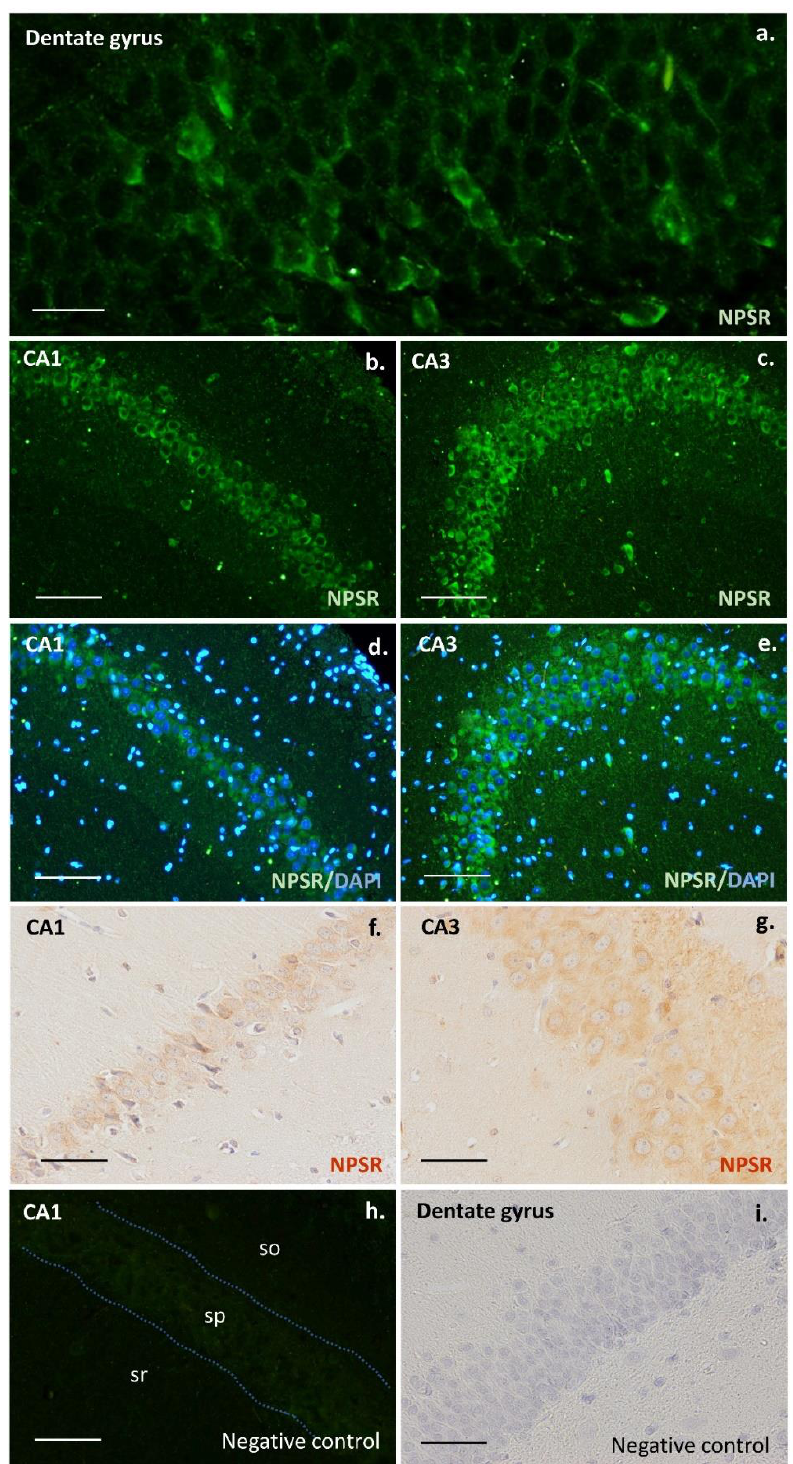
Figure 4. Neuropeptide S (NPSR) receptor-expressing neurons in the rat hippocampus. Immunopositive neurons in the dentate gyrus, CA1, and CA3 areas of control rats. Fluorescence, secondary antibody coupled with FITC ( a – e ). Immunoperoxidase reaction with DAB staining ( f , g ). Negative controls with omission of primary antibody against rat NPSR ( h , i ). Scale bars: 20 μm ( a ), 100 μm ( g ), 200 μm ( b – f , h , i ). Images captured with Nikon Eclipse Ti microscope.